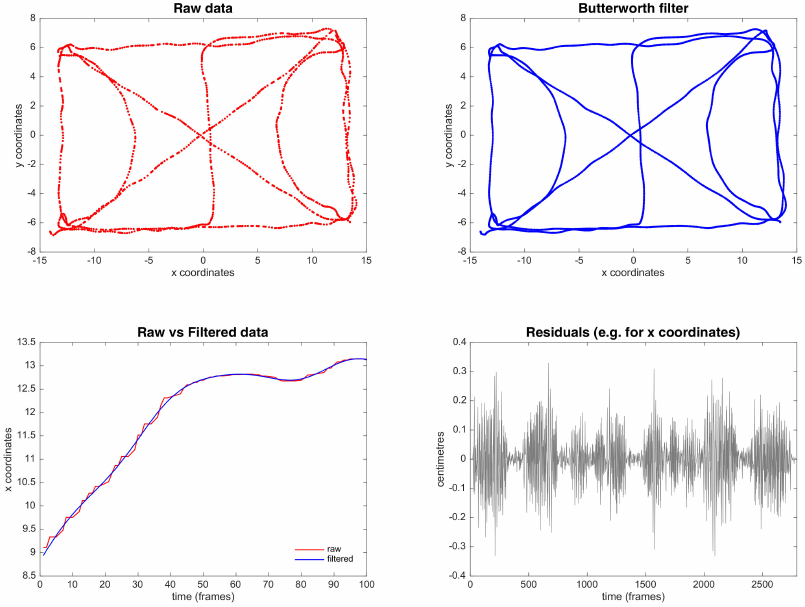
Figure 4. Comparison between raw and smoothing coordinate data, using Butterworth low-pass